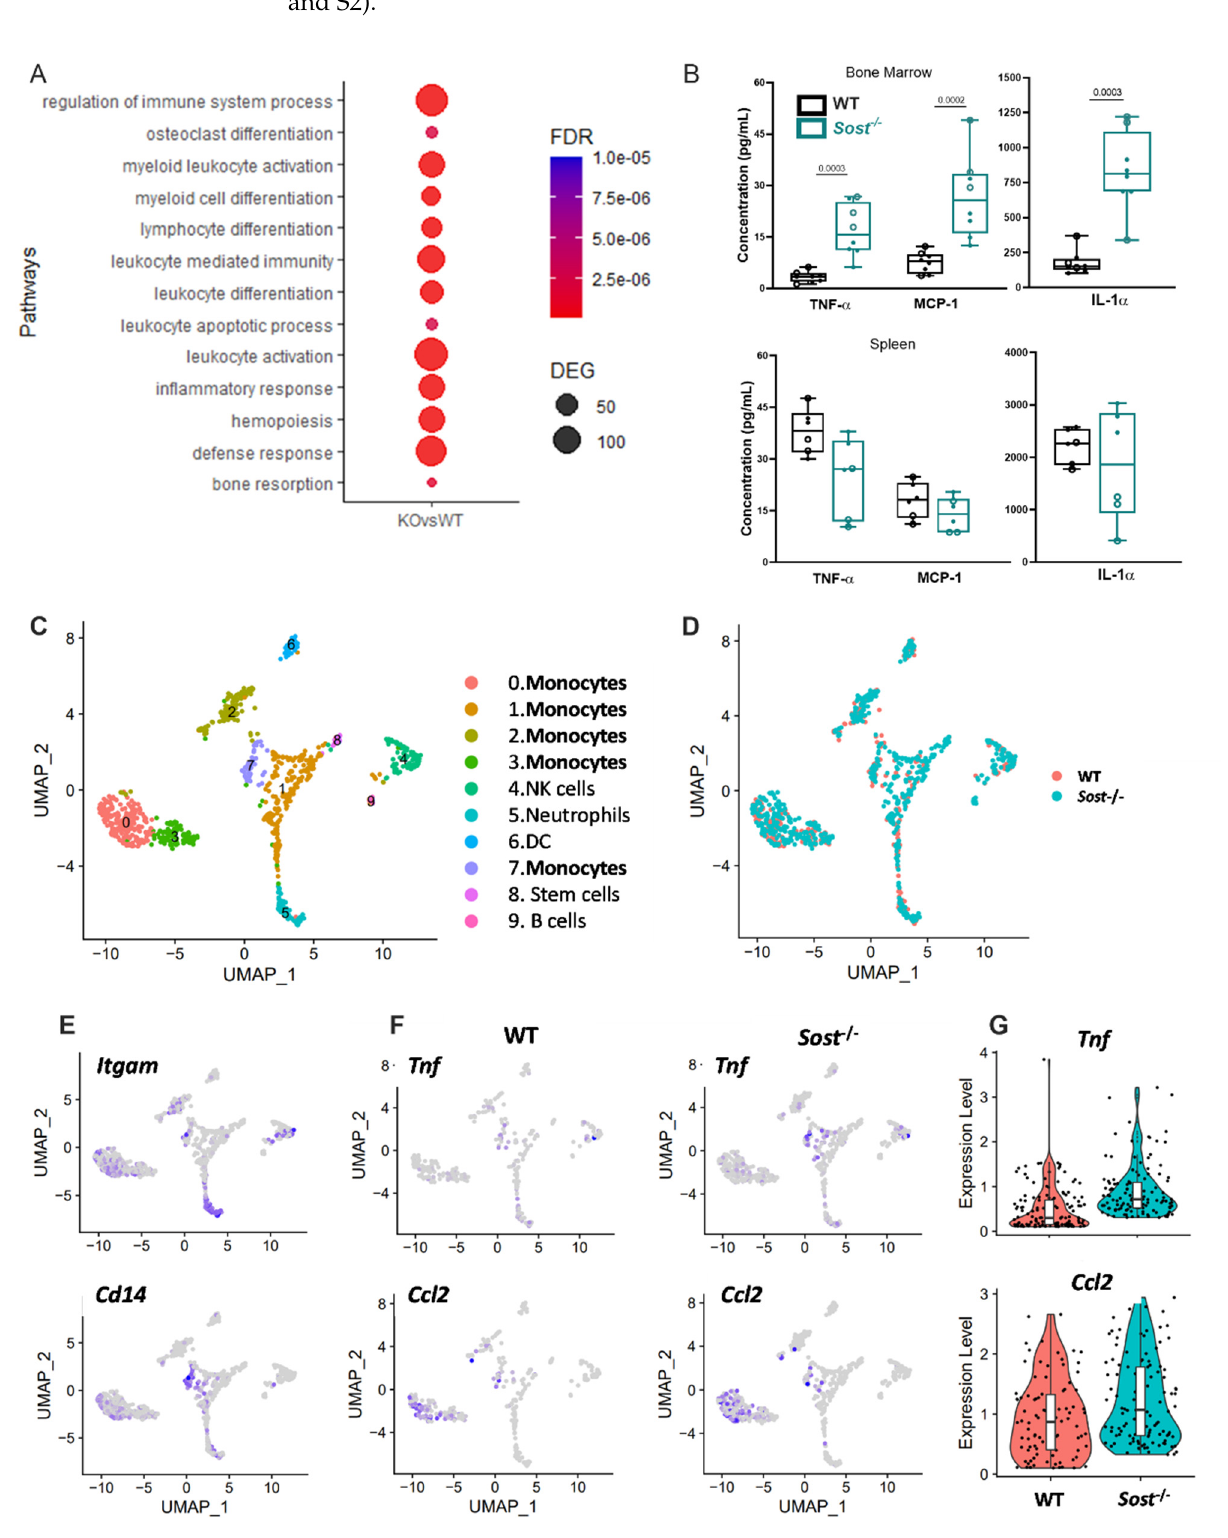
Figure 4. Elevated levels of inflammatory cytokines in Sost − / − bone marrow. ( A ) Dot plot showing enriched gene ontology categories in bulk RNA-seq analysis of LT-HSCs sorted from WT → Sost − / − bone marrow chimeras compared to WT → WT chimeras; ( B ) TNF α , MCP-1, and IL-1 α concentrations in WT and Sost − / − bone marrow (top) and spleen (bottom). Open circles represent male mice and filled circles represent female mice. Male (4 WT and 4 Sost − / − ) and female (4 WT and 4 Sost − / − ) mice ranging in ages of 25–36 weeks were used. All samples were analyzed using a single LEGENDPLEX kit. The actual p -values are shown, underlined. ( C ) UMAP plots showing immune cell clusters in scRNA-seq analysis of residual bone marrow cells remaining after depletion of CD45 + cells and collagenase digestion of WT and Sost − / − bones. Cell clusters